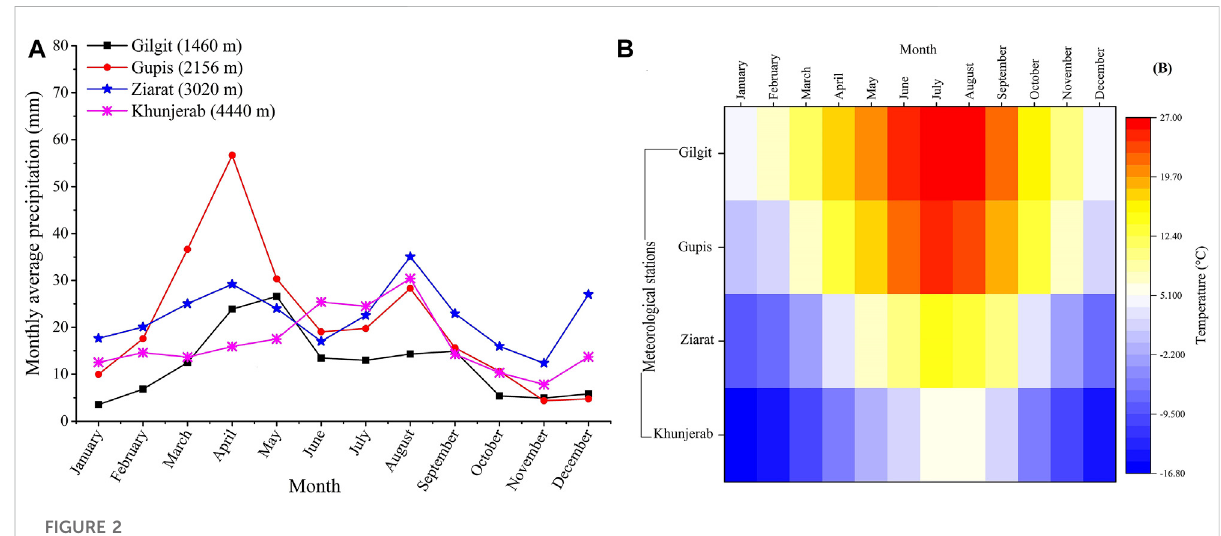
FIGURE 2 Variations in monthly average, (A) precipitation, and (B) Temperature with respect to altitude in the Gilgit River basin.